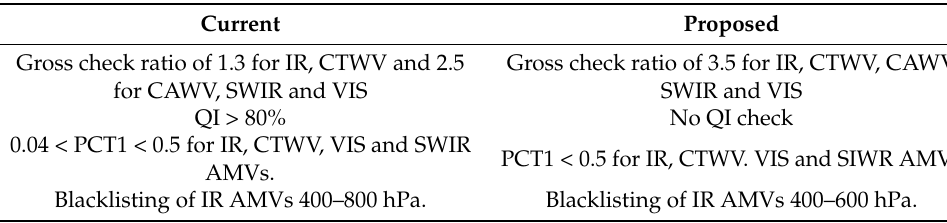
Table 3. List of current and proposed QCs and gross ratios for HWRF. Current Proposed Gross check ratio of 1.3 for IR, CTWV and 2.5 Gross check ratio of 3.5 for IR, CTWV, CAWV, for CAWV, SWIR and VIS SWIR and VIS QI > 80% No QI check 0.04 < PCT1 < 0.5 for IR, CTWV, VIS and SWIR PCT1 < 0.5 for IR, CTWV. VIS and SIWR AMVs AMVs. Blacklisting of IR AMVs 400–800